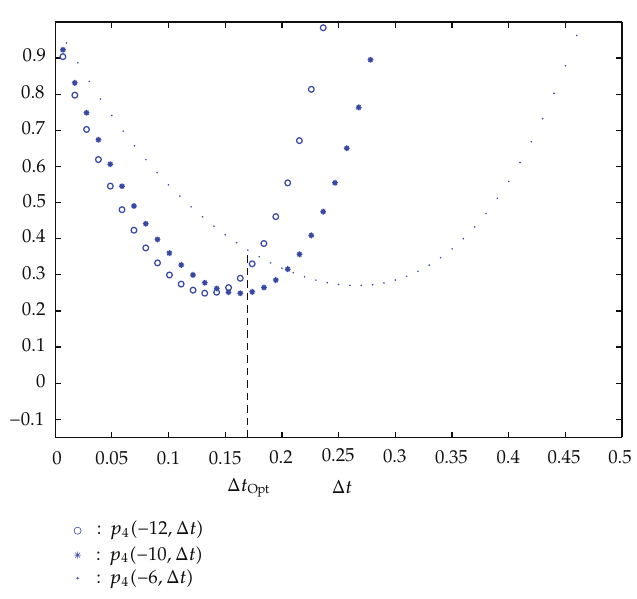
Figure 2: Graphs for p 4 (cid:9) a, Δ t (cid:10) where a (cid:6) − 6: · , a (cid:6) − 10: ∗ , a (cid:6) − 12: ◦